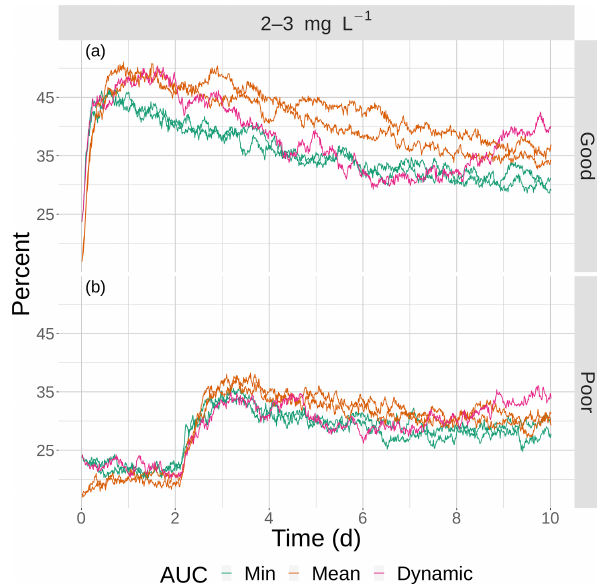
Figure 13. The percentage of fish exposed to DO of 2–3mgL − 1 for good (a) and poor (b) competency for the four snapshot maps with moderate sublethal area and the dynamic version. Maps within the same AUC category (min and max) are shown with the same